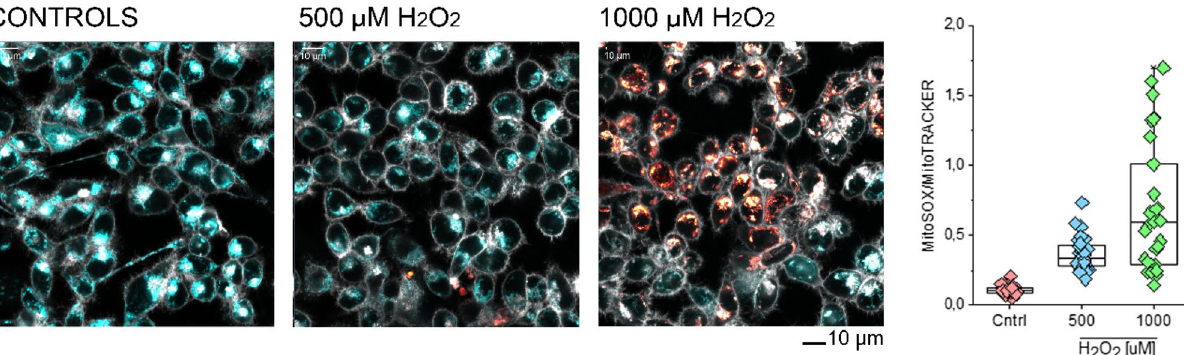
Figure 1. Live cell imaging: effect of hydrogen peroxide treatment. Representative images of the appearance of HCT116 colon cancer cells after staining with MitoSOX (orange, mitochondrial superoxide quantification) and MitoTracker (light blue, mitochondrial morphology). The plasma membrane was counterstained with CellMask (depicted in grey). The increasing MitoSOX to MitoTracker signal ratio upon external hydrogen peroxide treatment (500–1000 µM) in comparison to controls (Cntrl) implies the accumulation of superoxide anions within the mitochondria. Both treatments were different in comparison to controls (Mann–Whitney test; p <